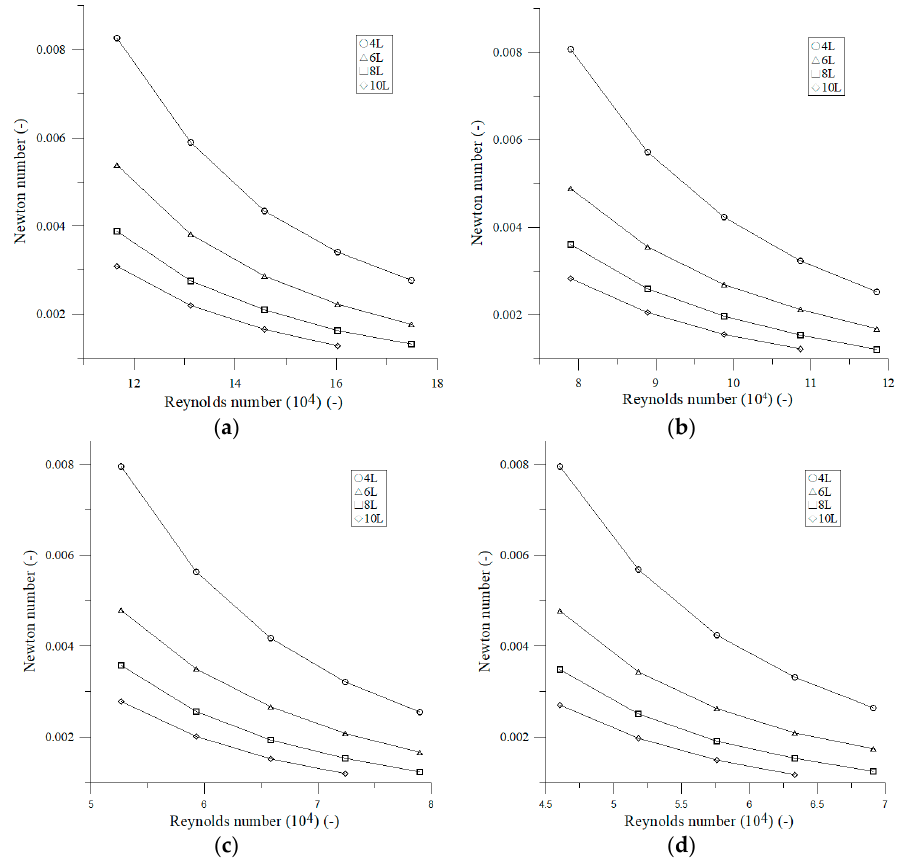
Figure 3. Relationship between Newton number and Reynolds number of di ff erent filling volumes. ( a ) Water; ( b ) 5 vol% glycerin; ( c ) 10 vol% glycerin; ( d ) 20 vol%